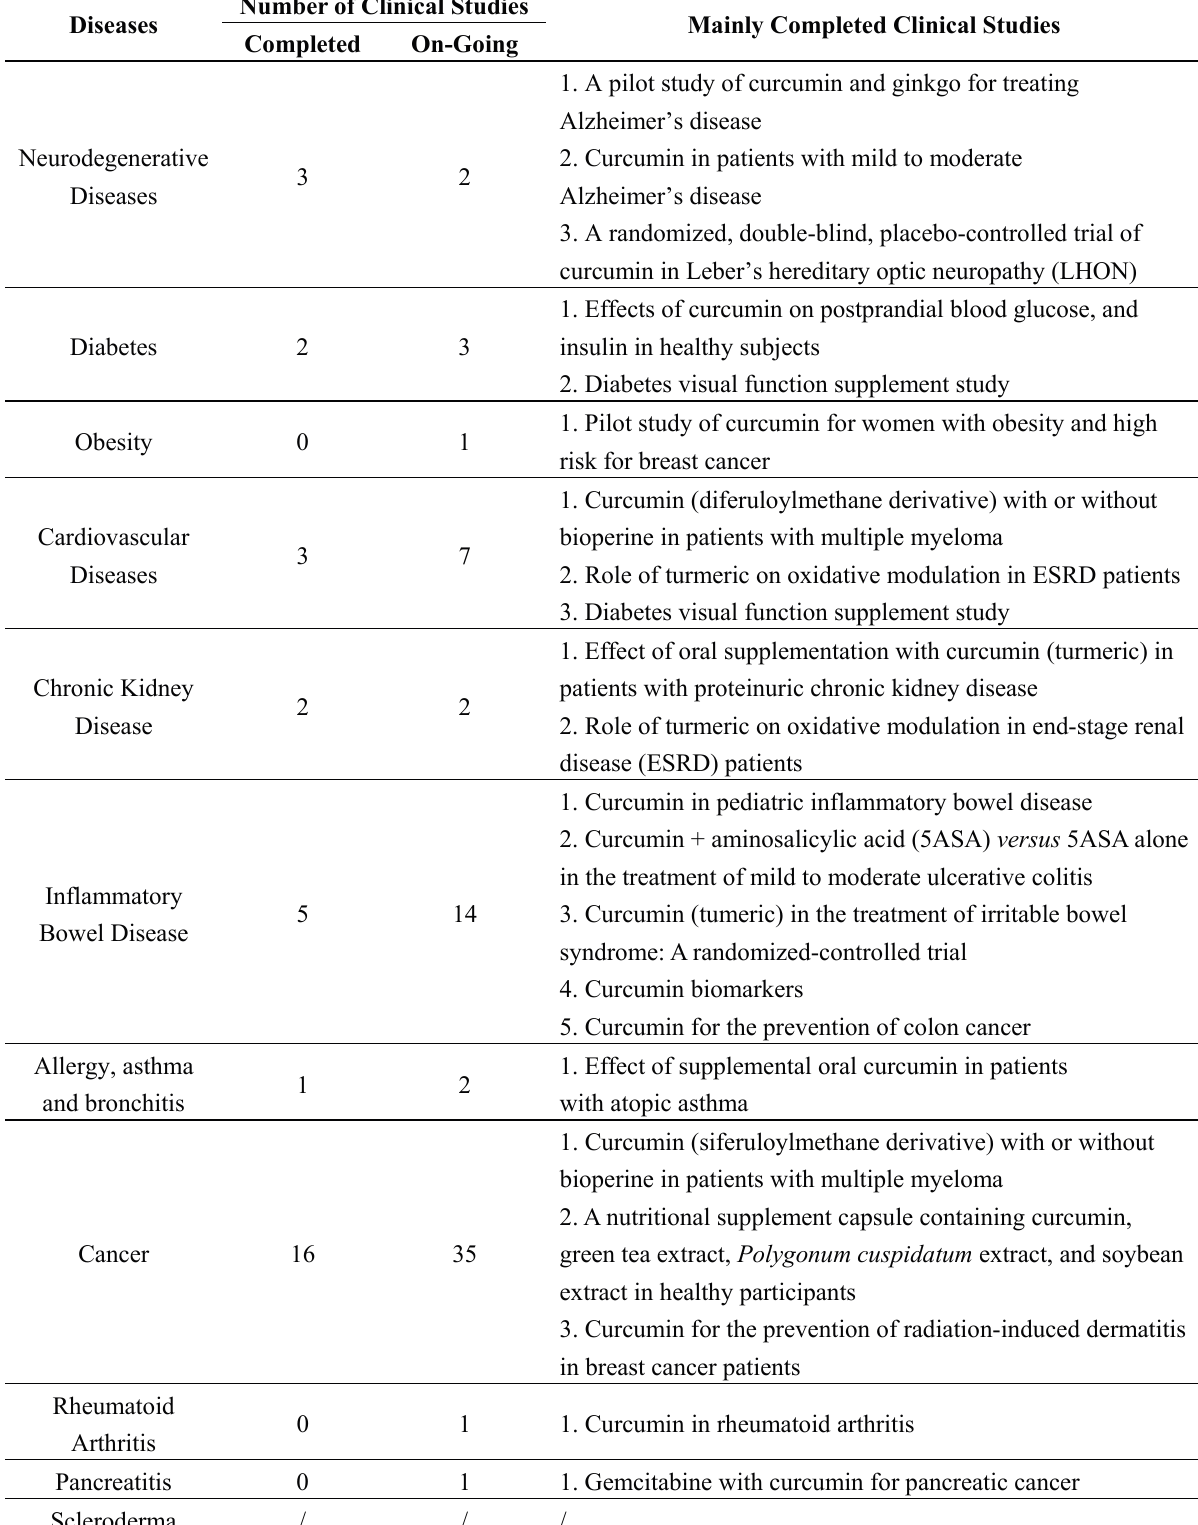
Table 2. Completed and on-going clinical studies of